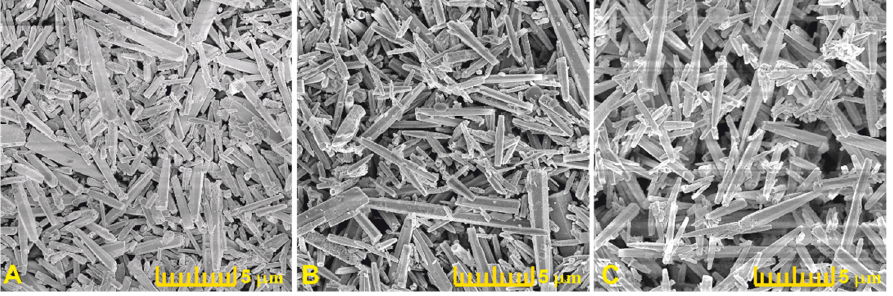
Figure 2. SEM images of the ZnO:Mo(0.05%) powder samples: ( A )—AG; ( B )—PH; ( C )—PO (see Experimental).